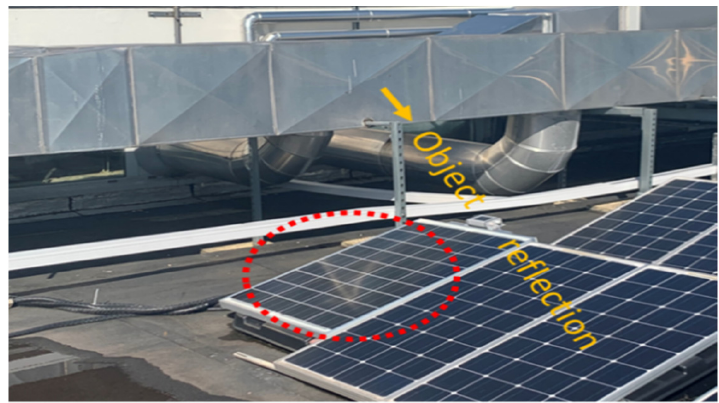
Figure 7. Over-illumination effect (circled in red) on the PV panel .